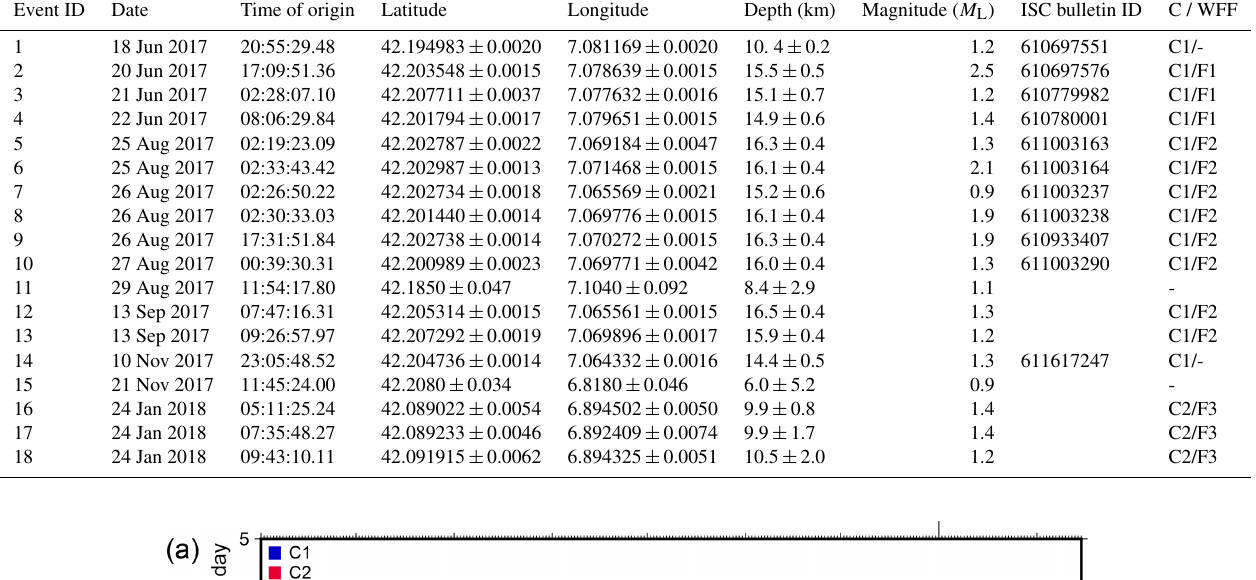
Table 1. Epicentral locations and focal depths (with uncertainties of the relative depths) for the cluster events from HypoDD (depth below sea surface). Abbreviations: C – cluster; WFF – waveform family; F – family.